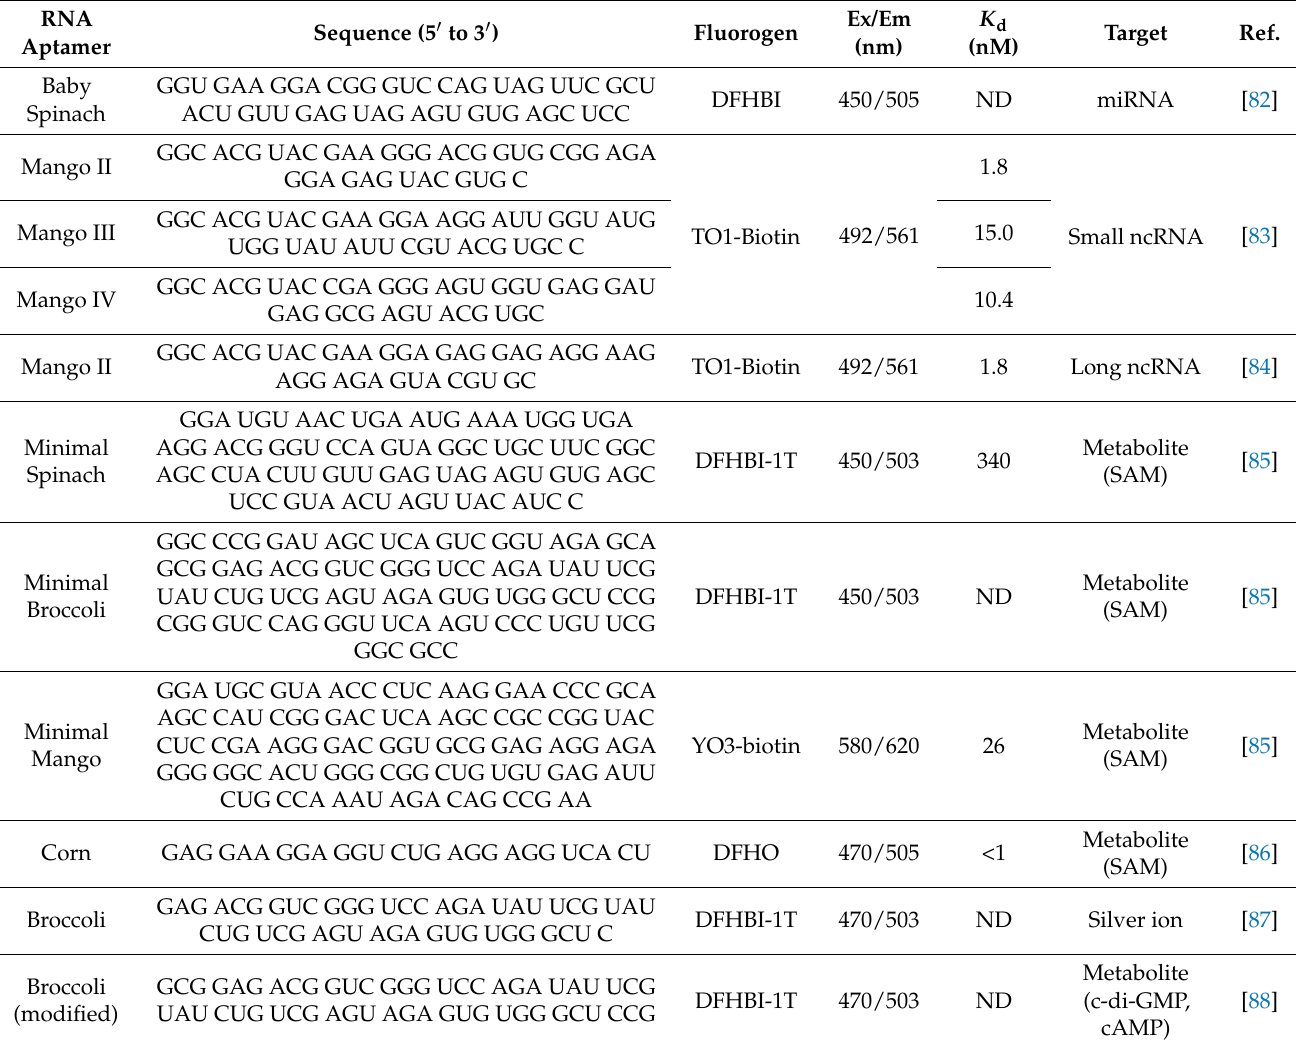
Table 1. List of FLAPs for Imaging RNAs or endogenous metabolites in living cells.